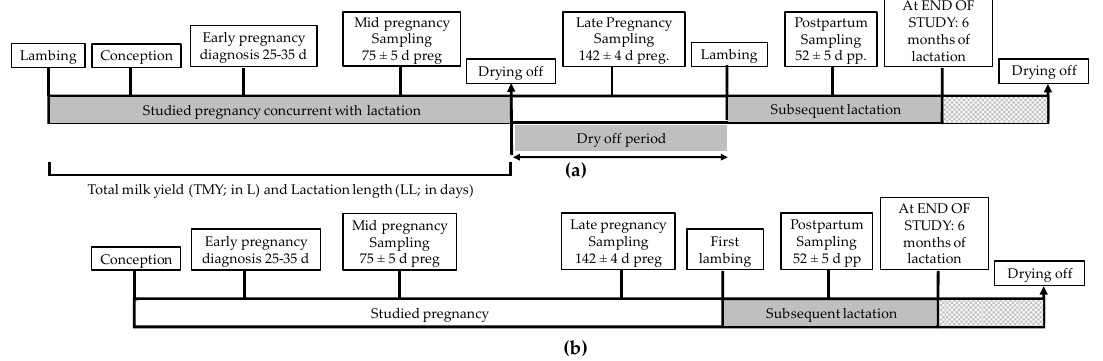
Figure 2. Timeline of assessments in mature ewes ( a ) and maiden sheep ( b ).